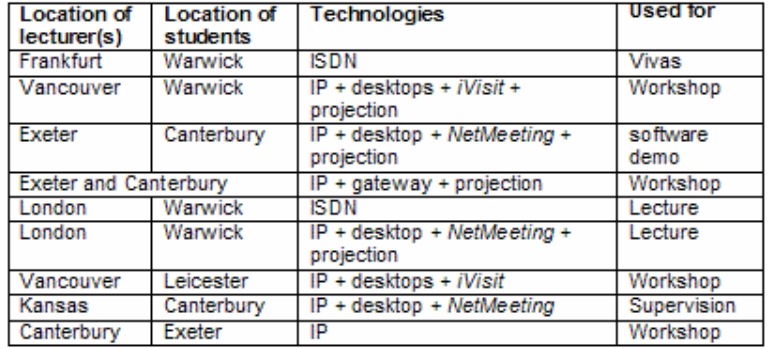
Evaluations of these sessions were carried out by focus groups with the students and by email. Interviews were held with the people conducting the lectures and with academic staff attending the sessions either as a facilitator or observer. The following analysis is based on these responses and on notes taken at the time of the